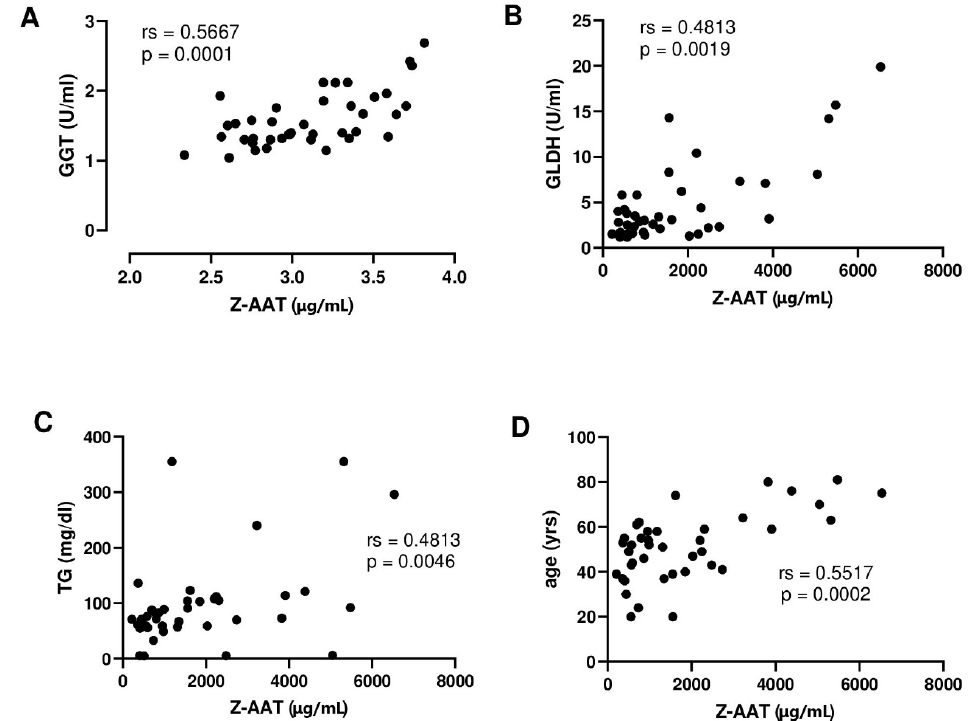
Figure 5. ( A – D ), Correlations between plasma levels of Z-AAT polymers and liver biomarkers and patient age: ( A ), the gamma-glutamyl transferase (GGT) values were log2 transformed; ( B ), glutamate dehydrogenase (GLDH), ( C ), triglycerides (TG), and ( D ) patient age Spearman correla- tion was calculated from 40 pairs of data and shows a significant correlation between plasma Z-AAT polymer levels and liver